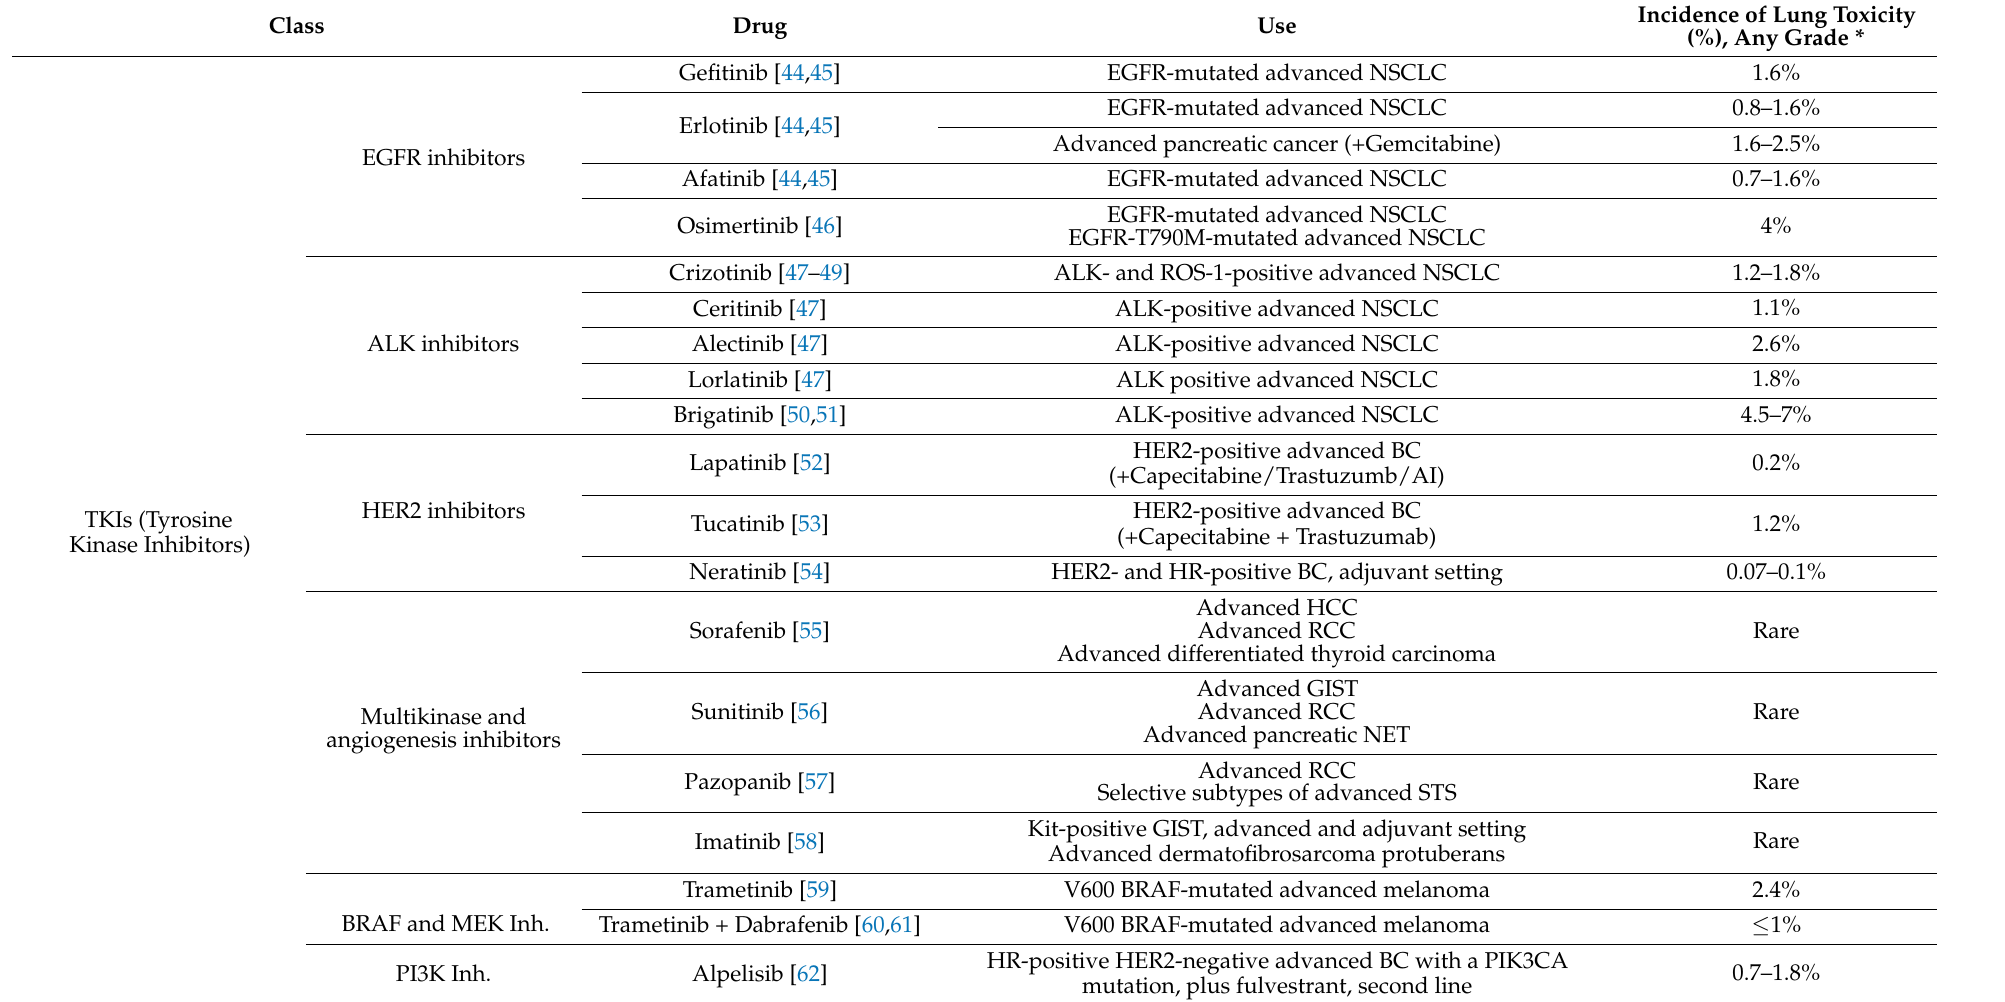
Table 2. Incidence of pneumonitis with targeted cancer therapies approved by the FDA and EMA in the treatment of solid